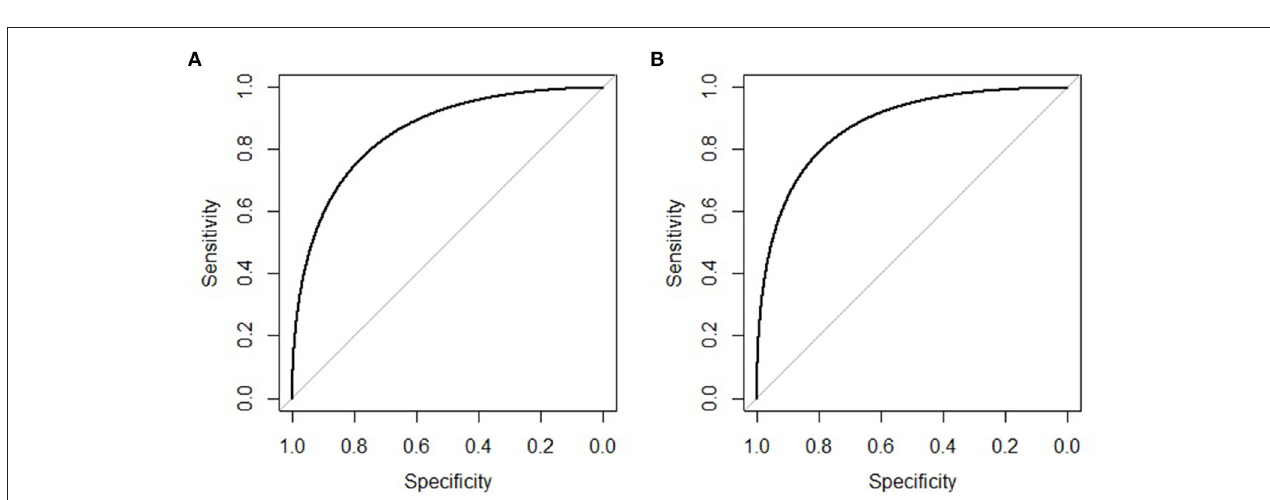
FIGURE 4 | Nomogram for predicting the risk of NAFLD in adults with visceral fat obesity.